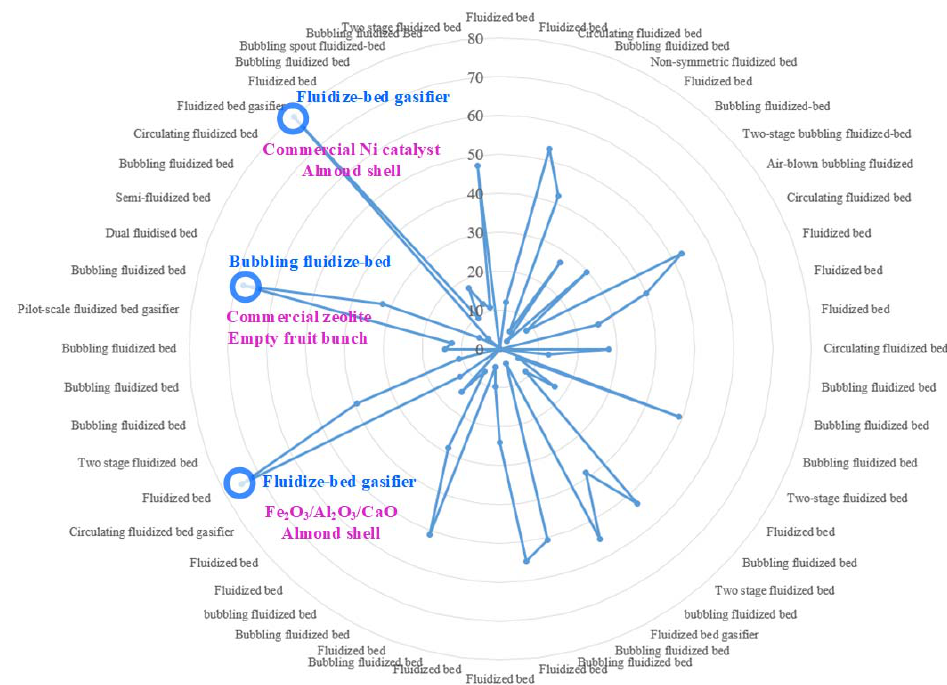
Figure 5. Types of fluidized bed versus hydrogen yield (vol-%), the circles with number labelled represent hydrogen yield (%) and the top three hydrogen yield case are displayed in blue and purple.